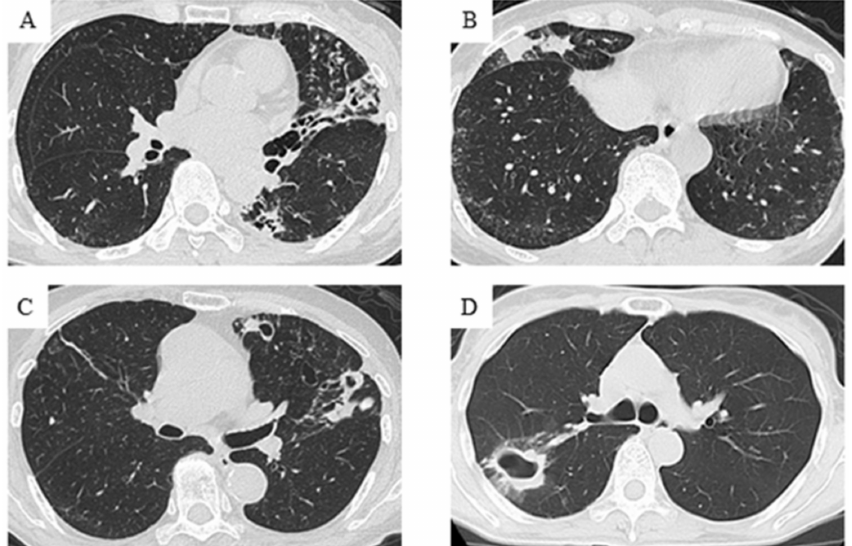
Figure 1. Chest computed tomography findings of representative patients. ( A – C ) Patients with multiple nodules and bronchiectasis were diagnosed with the NB form of MAC-PD. The NB form was further classified into non-cavitary NB ( A , B ) or cavitary NB ( C ) according to the absence or presence of cavitary lesions, respectively. ( D ) Patients with fibrocavitary lesions mainly in the upper lobes were diagnosed with the FC form of MAC-PD. NB, nodular bronchiectatic; MAC-PD, Mycobacterium avium complex pulmonary disease; FC,